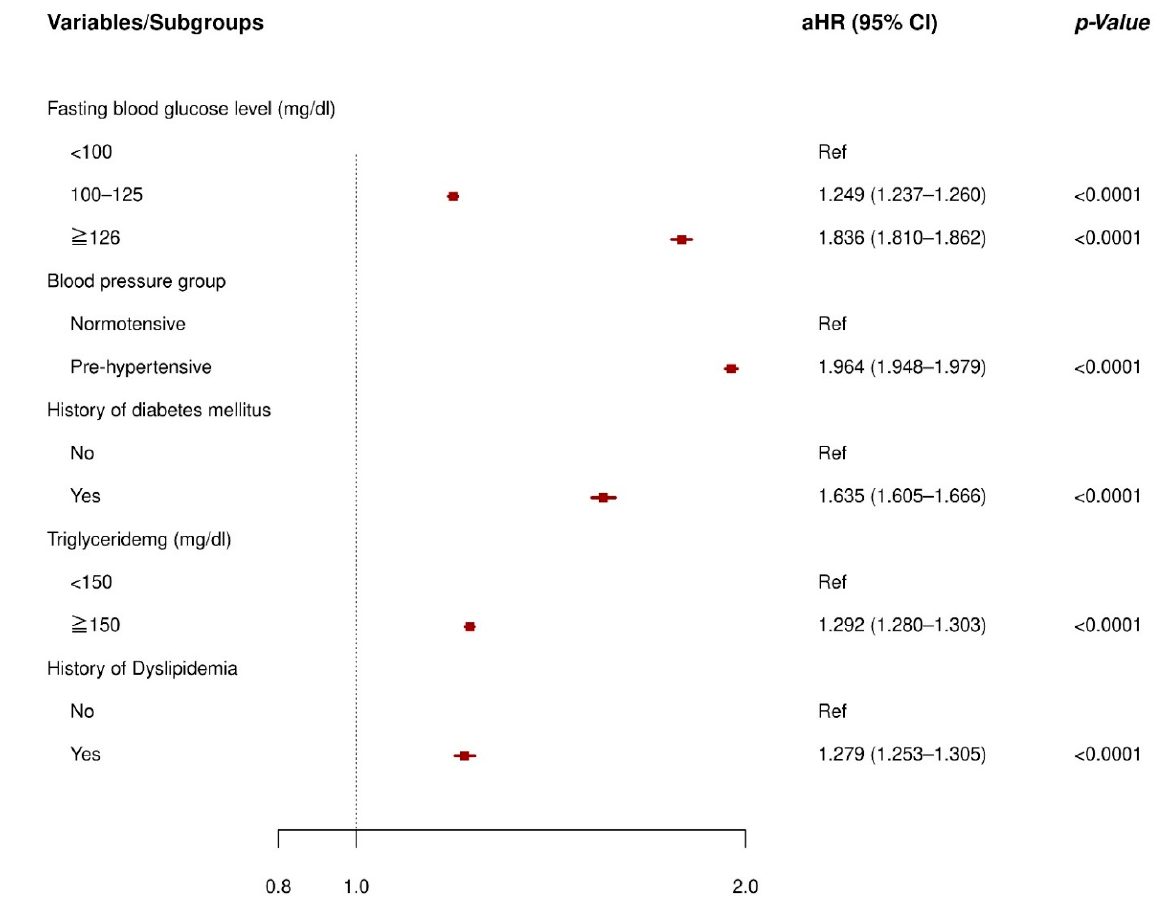
Figure 2. Forest plot of the adjusted Hazard ratio of incident hypertension. Abbreviations: aHR = adjusted Hazard Ratio; CI = Confidence Interval; Ref = Reference. Adjusted for age, sex, body mass index, waist circumference, high-density lipoprotein cholesterol, metabolic syndrome, current smoking, high risk alcohol drinking, optimal exercise, and household income.